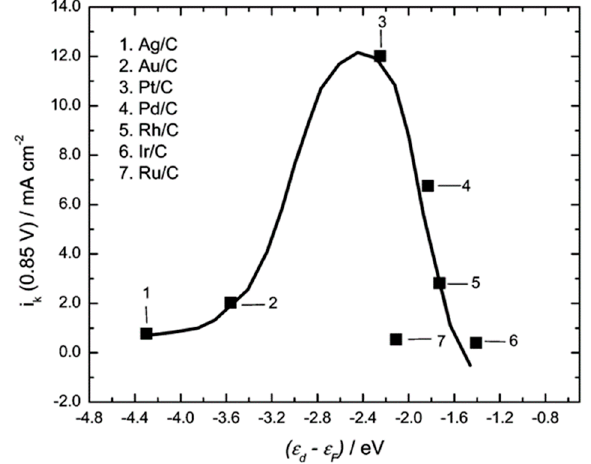
Figure 6. Kinetic current (i k ) at 0.80 V versus RHE for O 2 reduction on carbon-supported metal nanoparticles in a 0.1 mol L − 1 NaOH solution as a function of the metal d-band center. Reproduced with permission [72]. Copyright 2007, American Chemical Society.